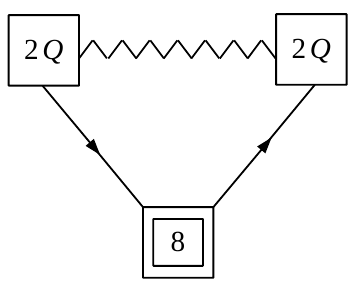
Figure 2: The basic tube theory: we couple the E [ USp ( 2 Q )] block to two sets of chiral fields in the fundamental and anti-fundamental representation of SU ( 8 ) re- spectively. We use simple circles and squares to denote gauge and flavor USp ( 2 n ) nodes and double-line squares to denote flavor SU ( k )